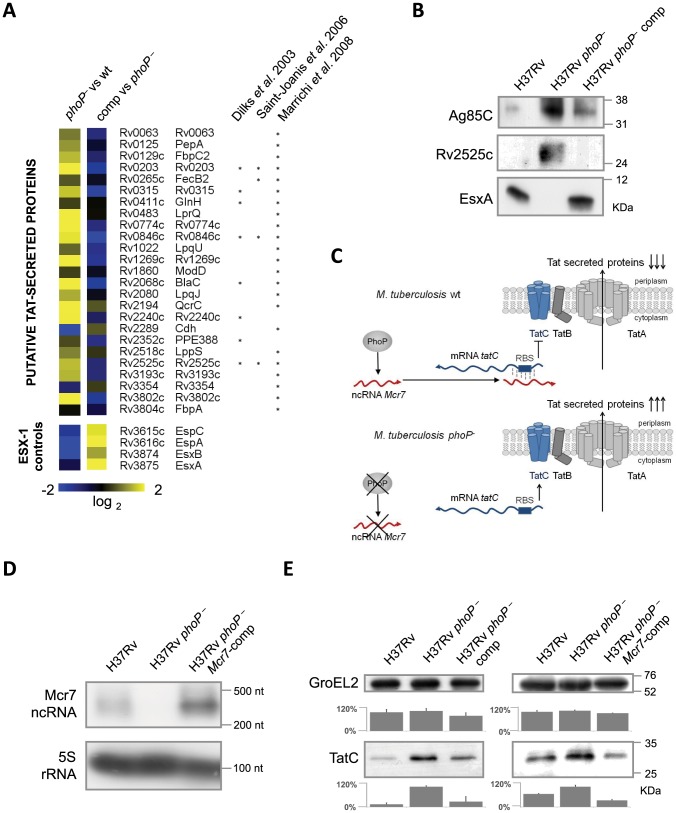
Analysis of the M. tuberculosis secretome identifies a high proportion of Tat substrates enriched in the M. tuberculosis phoP mutant.
A. Heat map displaying values from in-depth proteomic quantifications of the secreted protein fraction. Values for EsxA, EsxB, EspA and EspC are displayed as internal controls since these proteins are barely detectable in the M. tuberculosis phoP mutant. The other proteins are representative examples of putative Tat-secreted substrates according to [24], [26], [27]. Note the opposite trend between EsxA/EsxB/EspA/EspC and Tat-secreted proteins. B. Western blot analysis of Ag85C, Rv2525c and EsxA in M. tuberculosis wild type, phoP mutant and complemented strains. Results are representative of three independent experiments. C. Proposed regulatory network involving PhoP, Mcr7 and tatC. PhoP controls transcription of Mcr7 (red transcript), which anneals to the 5′-end of the tatC mRNA (blue transcript) occluding the RBS (boxed) and consequently impairing translation of TatC. D. Northern blot analysis of Mcr7 in wild type, phoP mutant and mcr7-complemented strains of M. tuberculosis. Introduction of mcr7 under the 16S rRNA promoter in a phoP mutant efficiently restores production of this molecule. Expression of the 5S rRNA is used as a control of RNA loaded in each lane. E. Analysis of TatC expression by Western blot in wild type, phoP mutant, phoP-complemented mutant and mcr7-complemented strains of M. tuberculosis. Note the higher expression levels of TatC in the phoP mutant compared to the wild type. Complementation of a phoP mutant with phoP or mcr7 restored wild type levels of TatC. GroEL2 is used as a control of protein loaded in each lane. Signal intensity was quantified from three independent experiments and plotted in the graphs below the Western blot images.